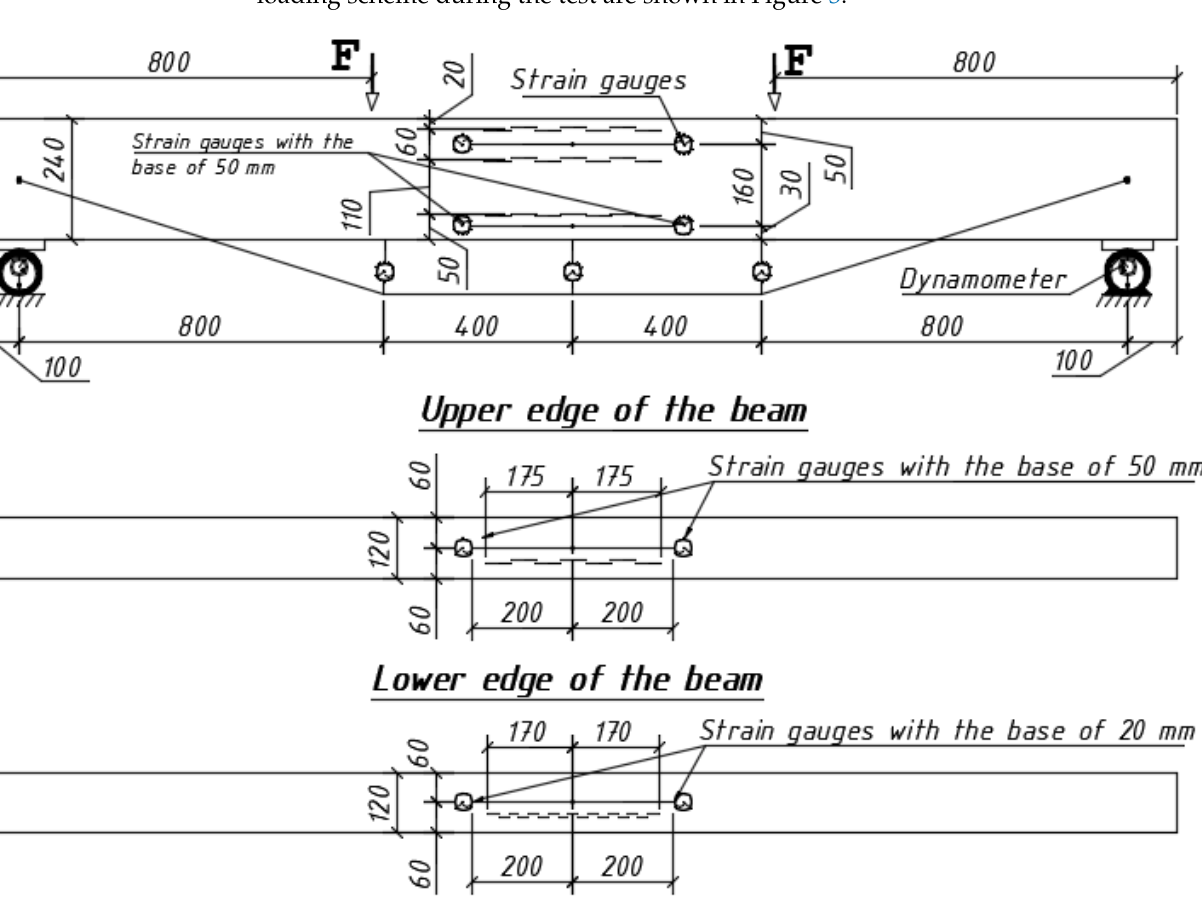
Figure 3. The location of measuring devices of the test samples and the loading scheme.